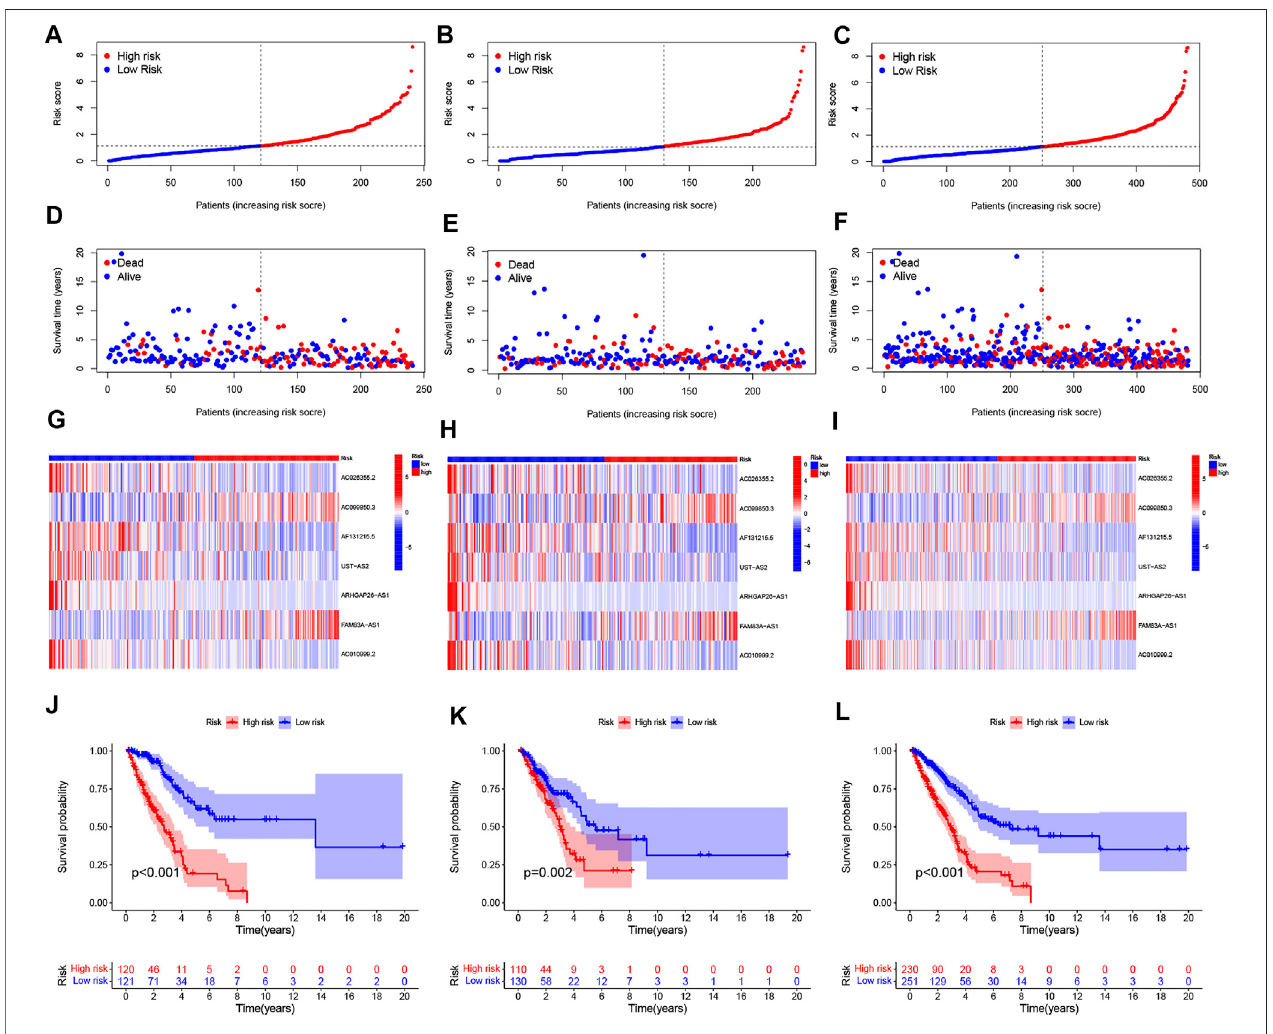
FIGURE2| Prognosisvaluesofthe7necroptosis-relatedlncRNAsignaturesinthetrain,test,andentiresets.Thedistributionofriskscores (A – C) ,survivaltimeand survival status (D – F) , heat maps of 7 lncRNA expressions (G – I) , and Kaplan – Meier survival curves of overall survival of LUAD patients (J – L) between low- and high-risk groups in the train, test, and entire sets,